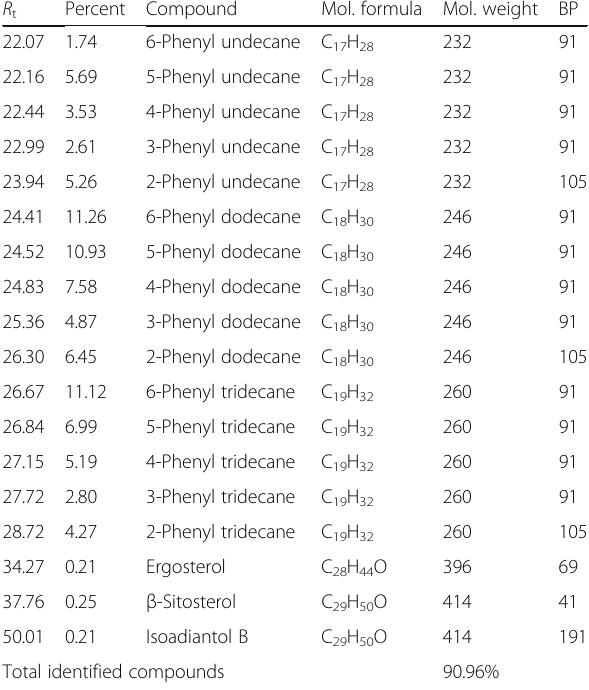
Table 4 GC ∕ MS of the unsaponifiable matter of P . ovata seeds R t Percent Compound Mol. formula Mol. weight